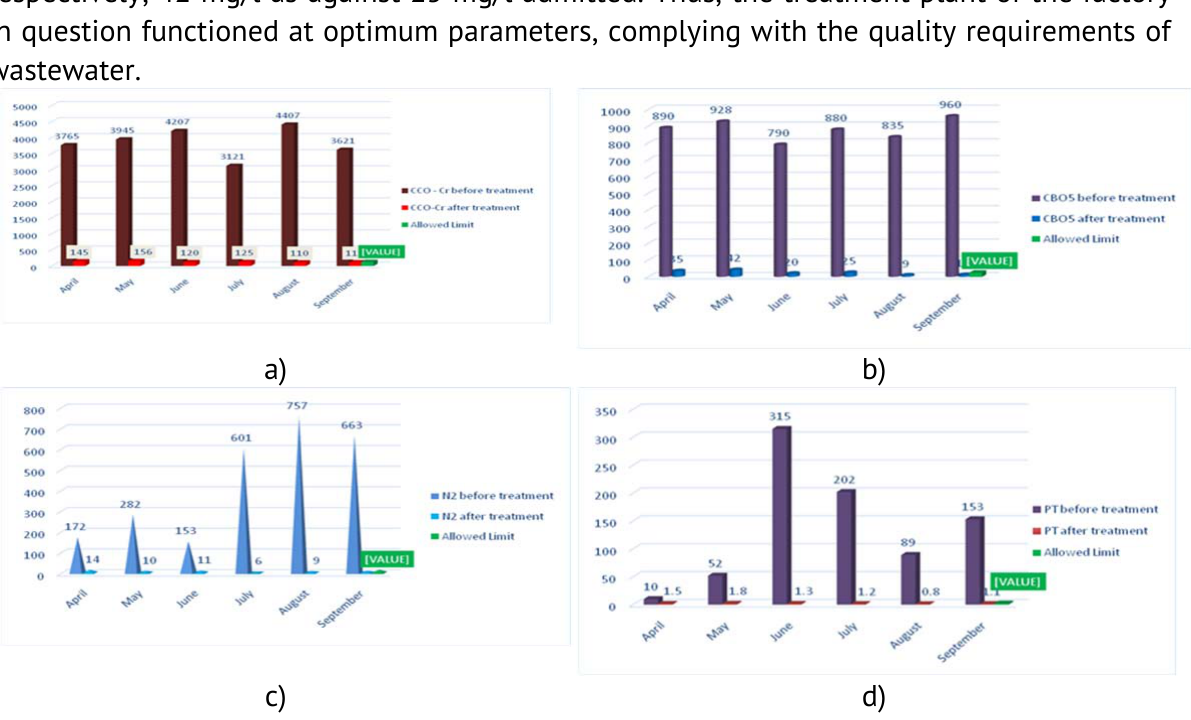
index (b), total nitrogen (c) and total Figure 2. Control results of CCO-Cr index (a), CBO 5 phosphorous (d) in wastewater